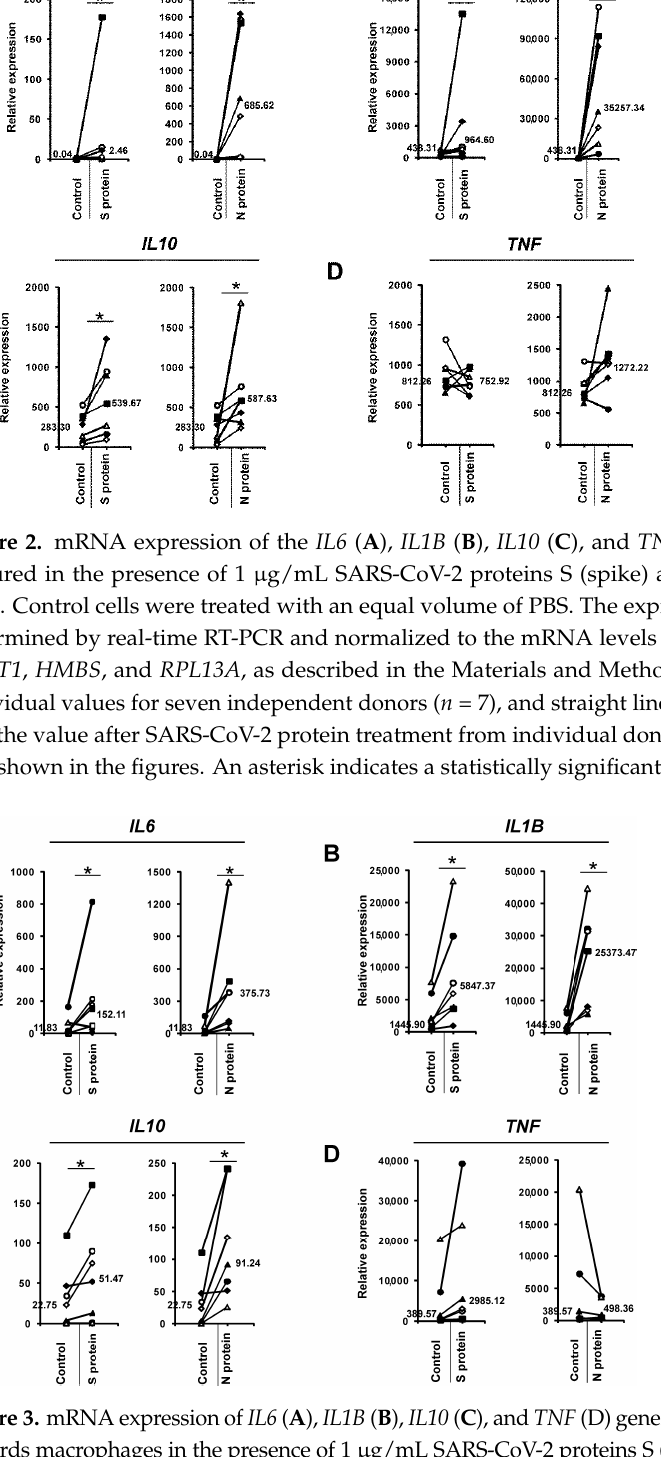
Figure 4. IL-6 production in the cellular supernatants of human monocytes ( A ) and macrophages ( B ) cultured in the presence of 1 μg/mL SARS -CoV-2 proteins S (spike) and N (nucleocapsid) was determined using the human IL-6 Quantikine ELISA Kit. Control cells were treated with an equal volume of PBS. The data show individual values for seven independent donors ( n = 7), and straight lines connect the control value and the value after SARS-CoV-2 protein treatment from individual donors. The median values are also shown in the figures. An asterisk indicates a statistically significant difference at p < 0.05.